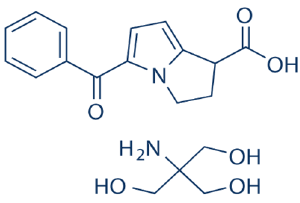
Figure 1. Ketorolac tromethamine (KT) chemical structure.